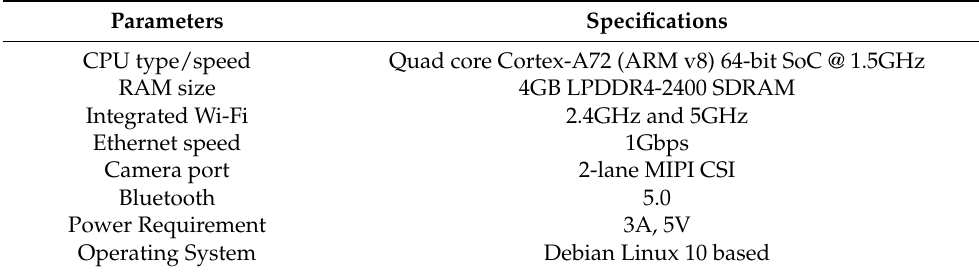
Table 2. Specification of the Raspberry Pi